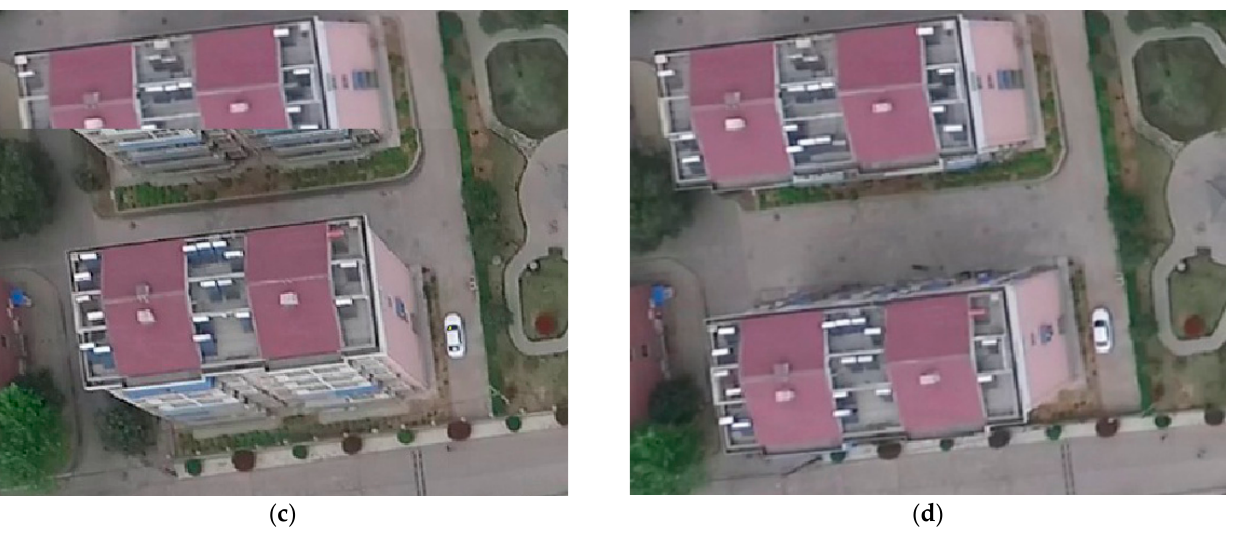
Figure 15. Compositing comparison of house in panorama using different fusion methods. ( a ) Simple coverage. ( b ) Weighted fusion. ( c ) Weight substitution. ( d ) Our method.